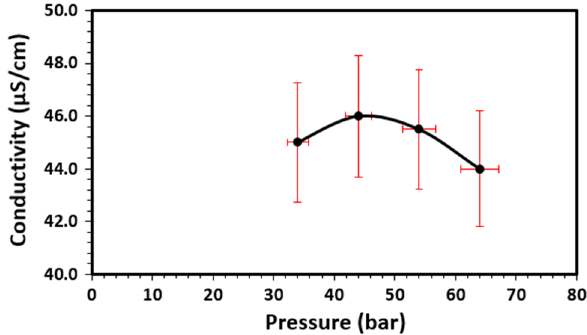
Fig. 12 Effect of different applied pressures on the pH value of the Red Sea water in membrane #2